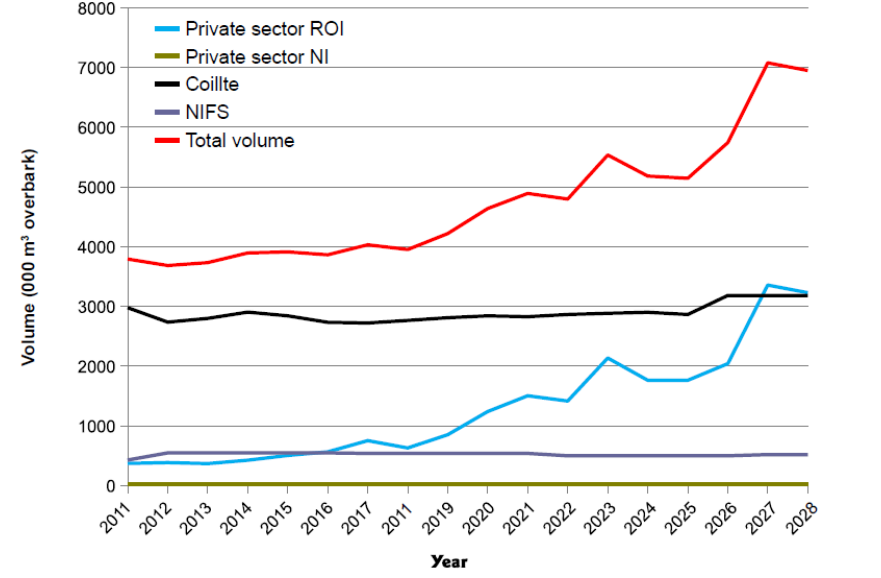
Figure 1. Forecast of net realisable volume production by sector [2]. Republic of Ireland (ROI), Northern Ireland (NI), Northern Ireland Forest Service